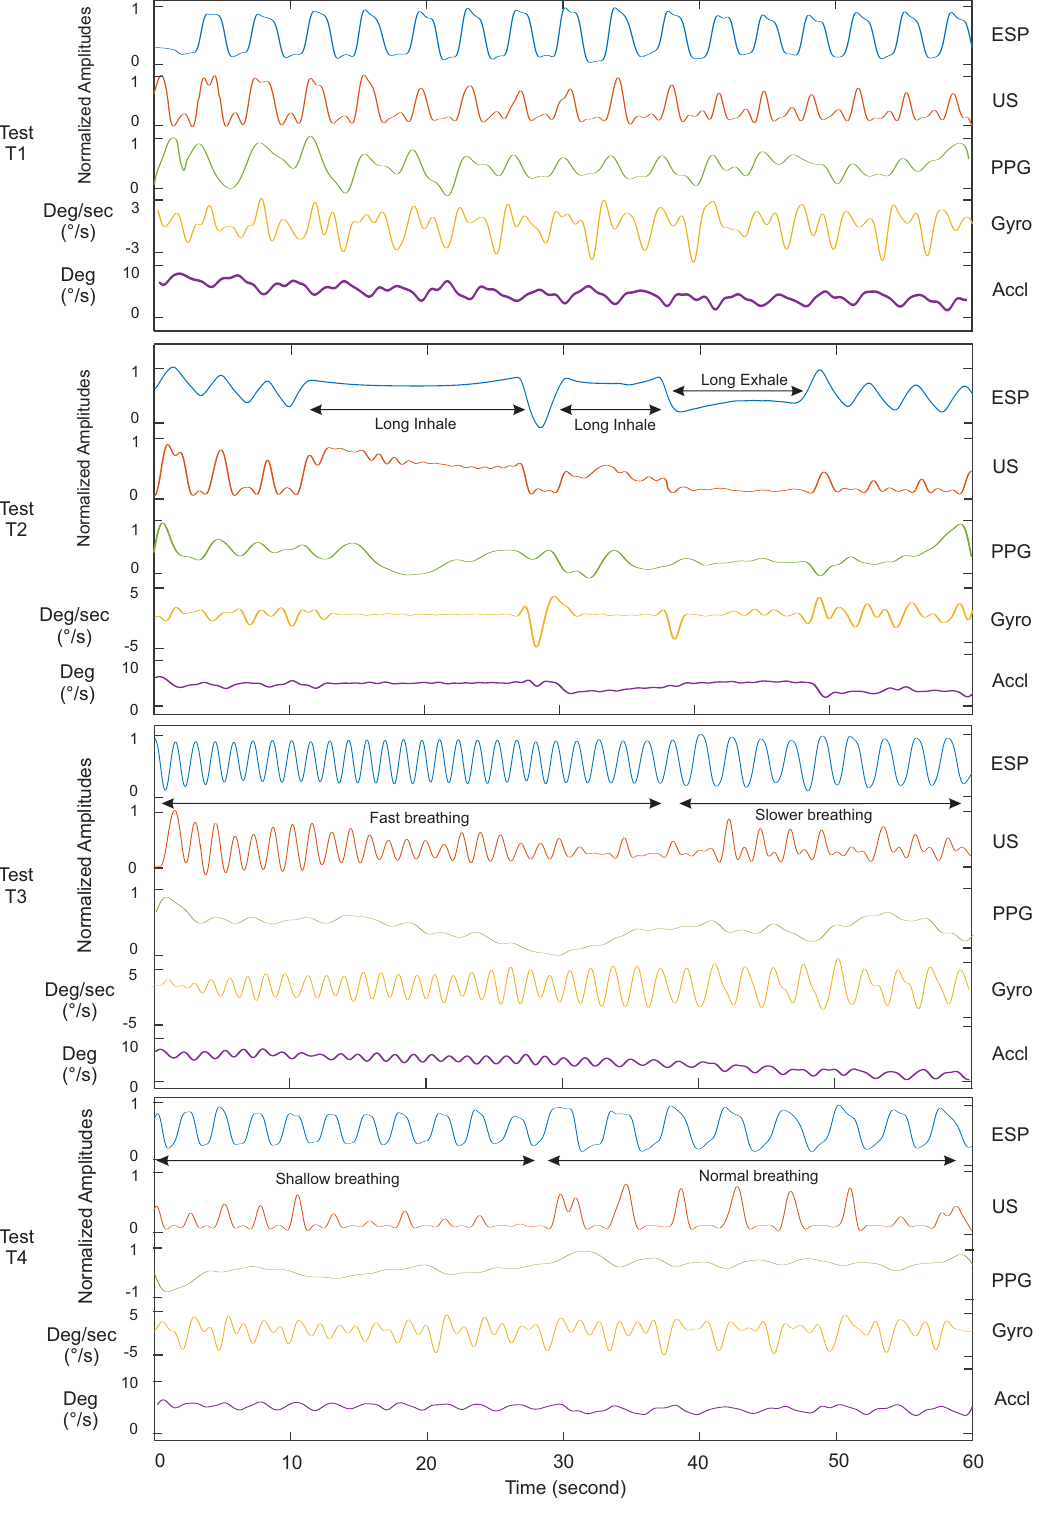
Figure 5. Respiratory waveforms of Subject 4 for the proposed ultrasound system (US) in comparison with the spirometer (ESP), pulse oximeter (PPG) and motion sensor (Accl/Gyro). Only four out of six types of experiments are plotted in static body conditions. All tests have close resemblance to real breathing